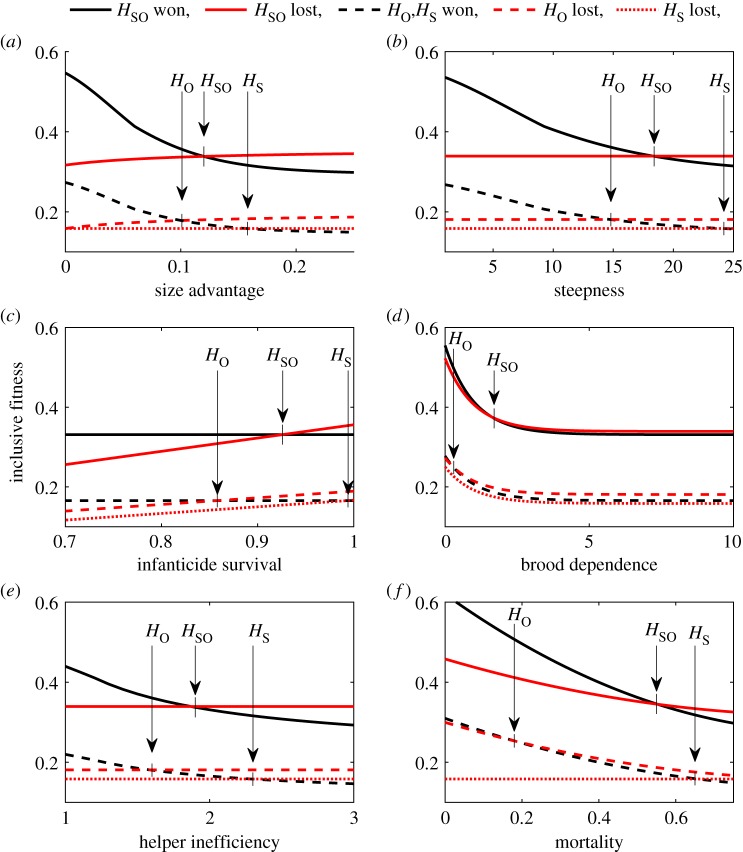
The helper's inclusive fitness when defending (becoming involved in the contest with the intruder) and defeating the intruder (black) and when not defending and the intruder takes over BS's position (red). Panels show inclusive fitness as functions of the (a) size difference between intruder and breeders (sI); (b) steepness of the threshold curve for involvement that is required to successfully defend against the intruder (k1); (c) probability of infanticide (μ); (d) duration of remaining brood dependence (k3); (e) helper inefficiency (k2); and (f) external mortality (1 − psurv). Solid lines refer to HSO, dashed lines to HO, and dotted lines to HS. In the case of defending and defeating the intruder, HO and HS can expect equal fitness returns (black dashes). Fixed parameters are: sI = 0.13, μ = 0.05, k1 = 20, k2 = 2, k3 = 10, psurv = 0.4. (Online version in colour.)